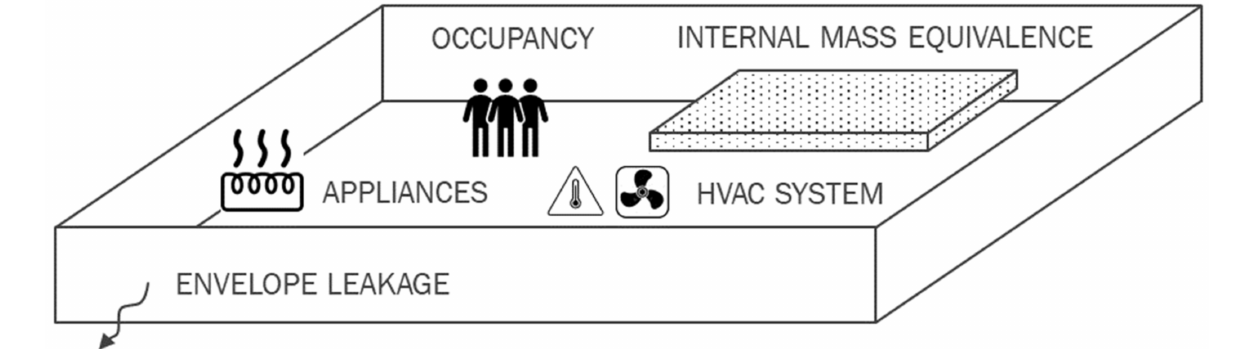
Figure 5. Model elements at the zone